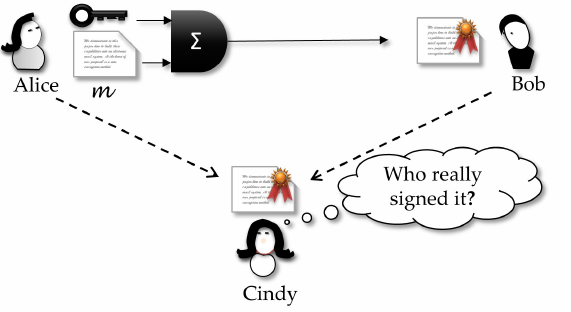
Figure 4. Bob is able to verify the validity of the signature as the designated verifier. The view of Cindy is that the signatures are indistinguishable of any other created by